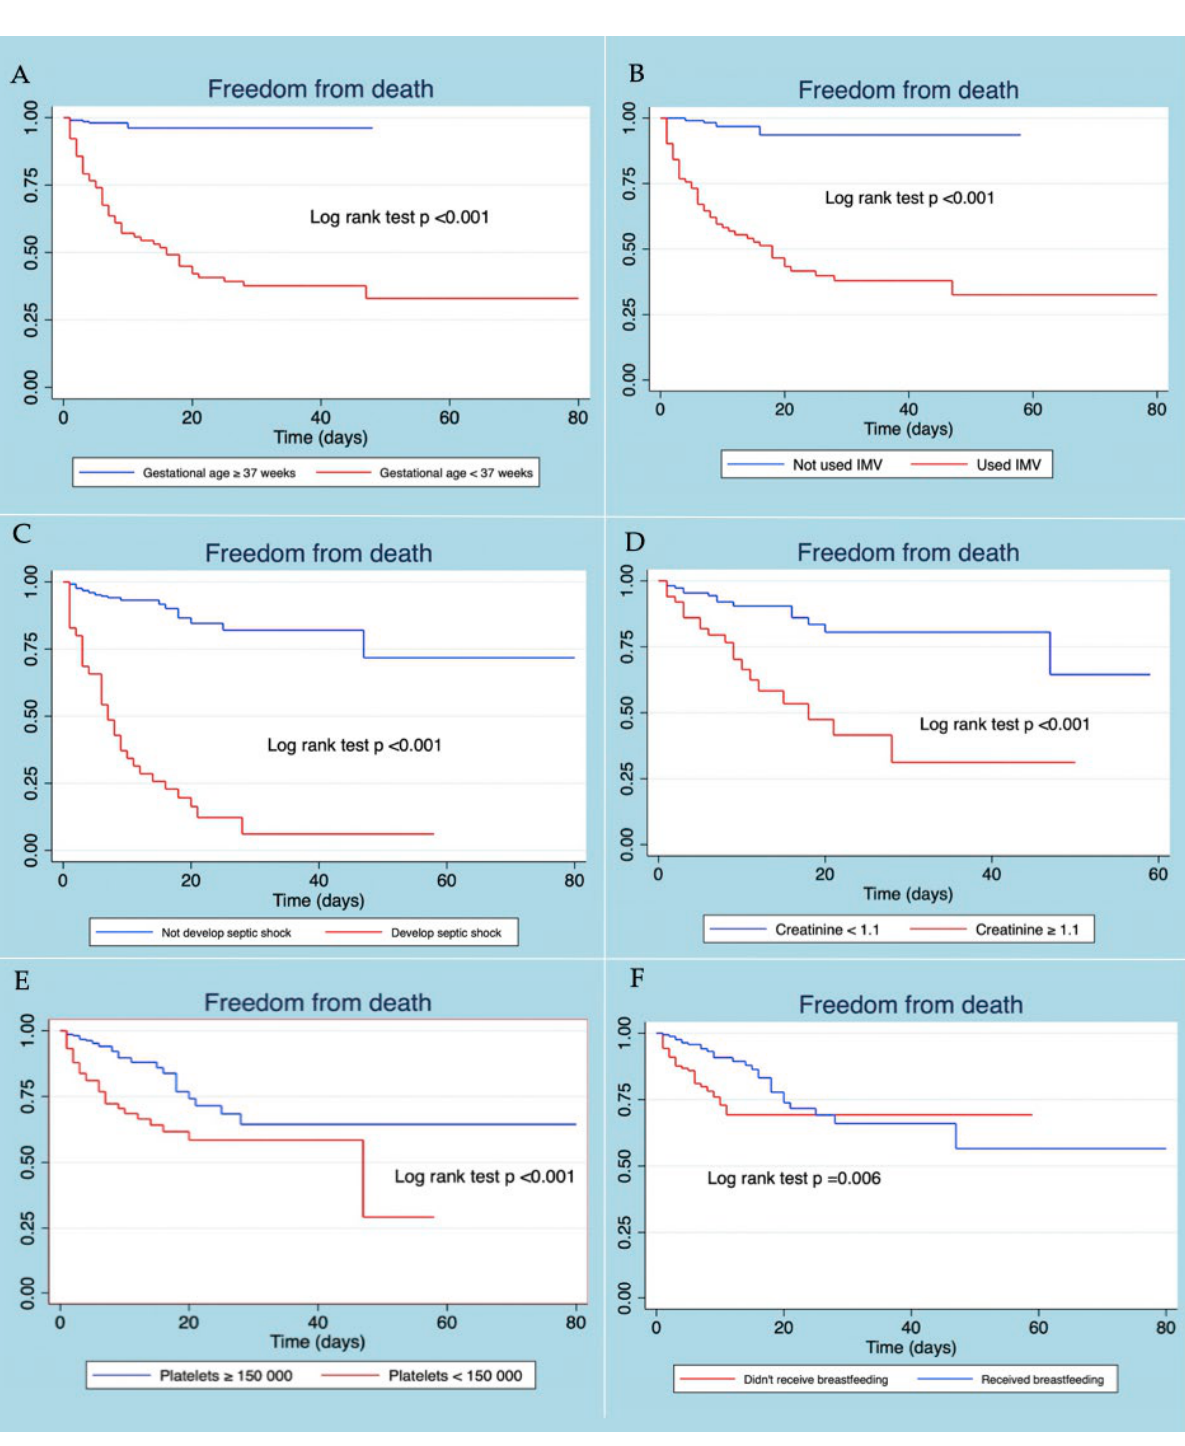
Figure 2. Kaplan–Meier survival curves according to gestational age ( A ), use of VMI ( B ), developed septic shock ( C ), creatinine level ( D ), platelet level ( E ), and received breastfeeding ( F ).